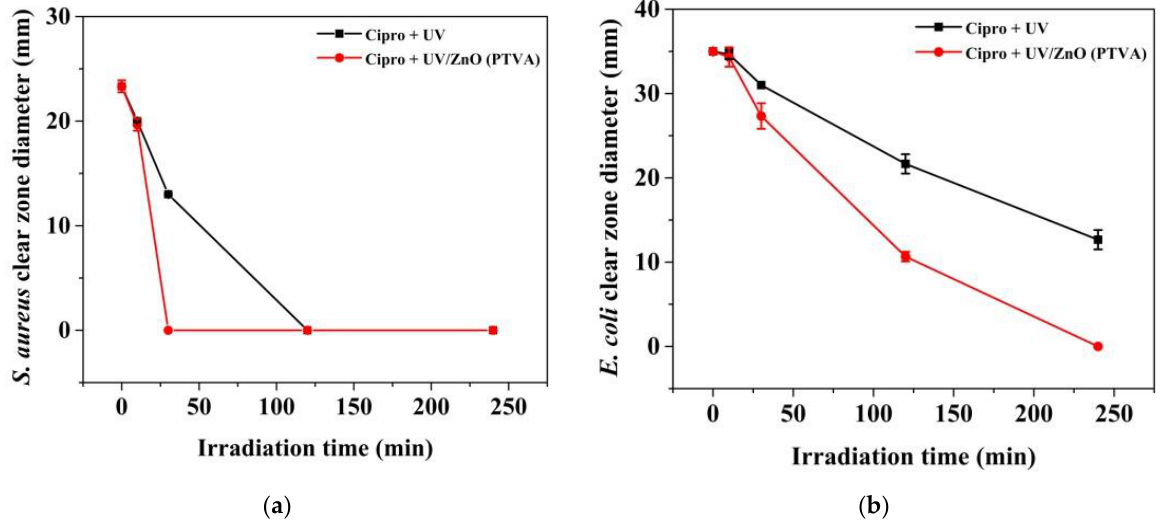
Figure 9. The inhibition-zone diameter of Cipro before and after irradiation in absence or presence of photocatalyst measured for Staphylococcus aureus ATCC 25923 ( a ) and Escherichia coli ATCC 8739 ( b ).